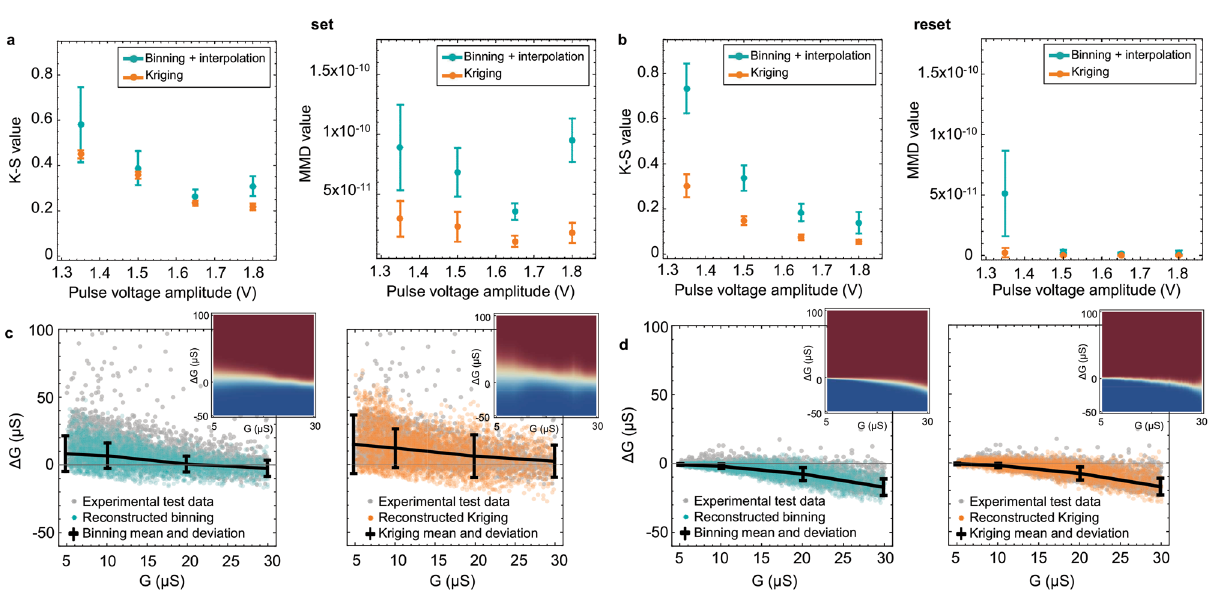
Figure 6. Results for experimental test data. K–S test and MMD metrics of test data vs. reconstructed data for four pulse amplitudes ( a ) set and ( b ) reset. # Points = 4000 experimental/reconstructed data points,